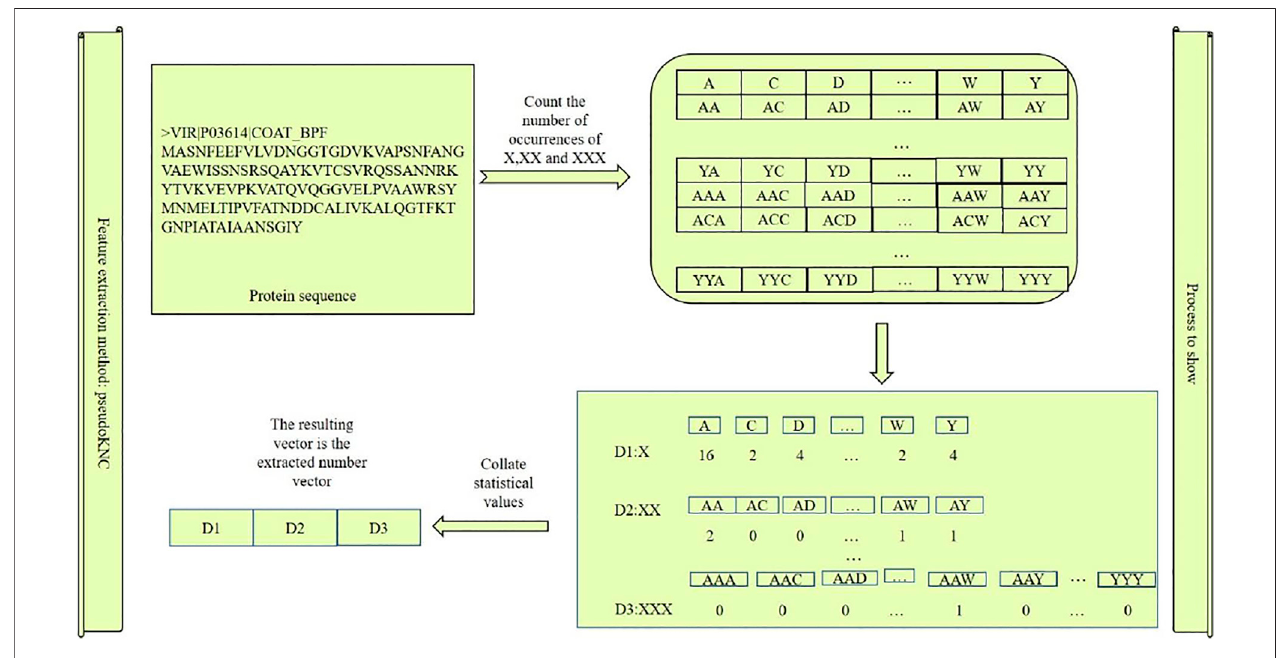
FIGURE 2 | Extraction process of vector features by